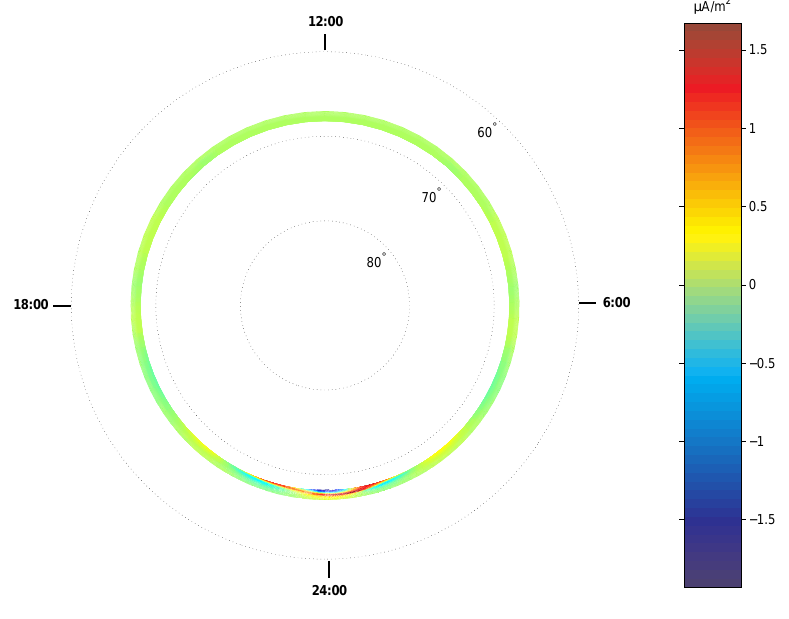
Fig. 9. Field-aligned current density J k in the ionosphere (at 1 R E in our model) for the equilibrium with GEOTAIL pressure.